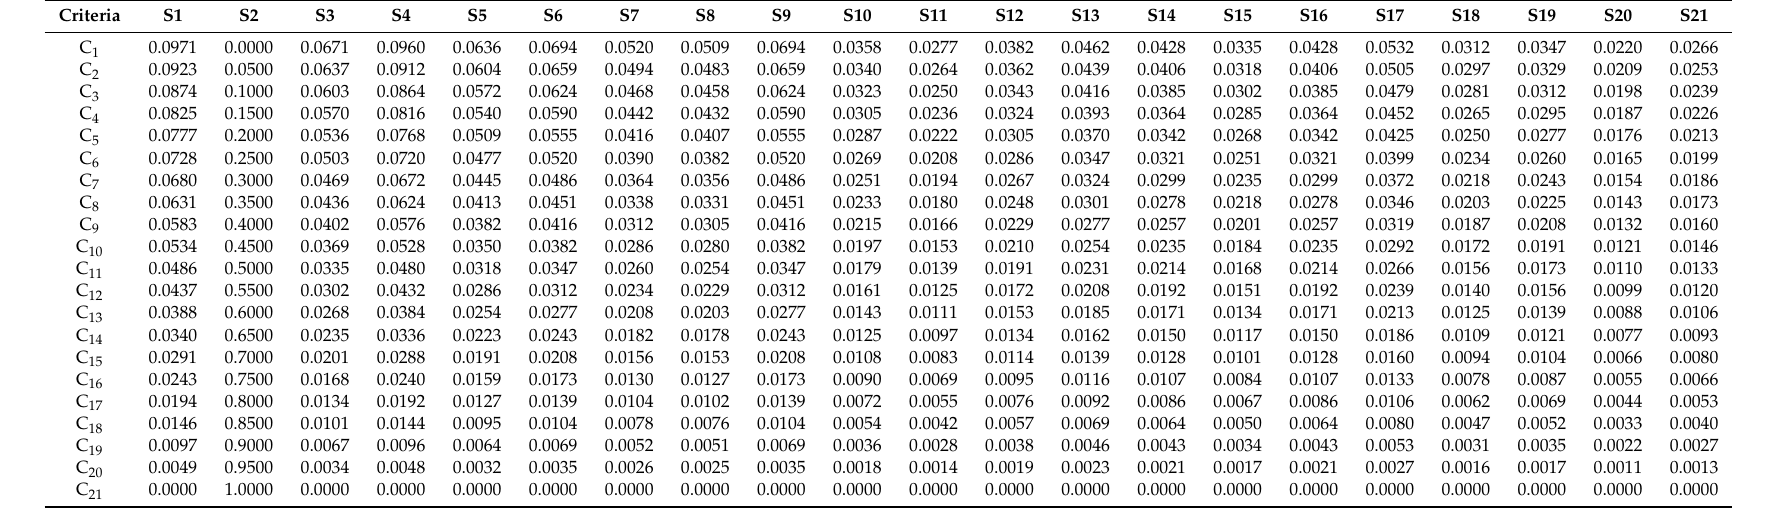
Table 7. Formed scenarios with new criteria